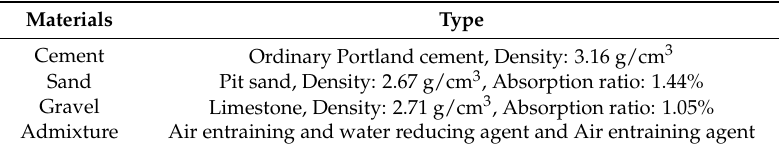
Table 2. Materials used.